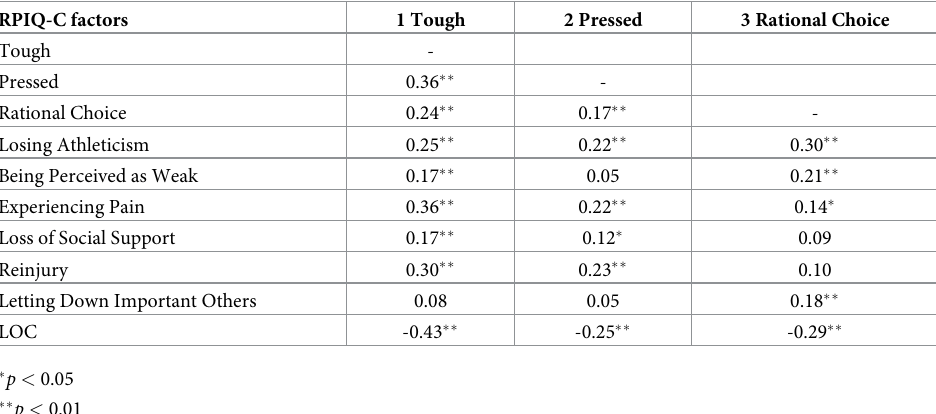
Table 3. Correlations between the RPIQ-C factors, SIAS and